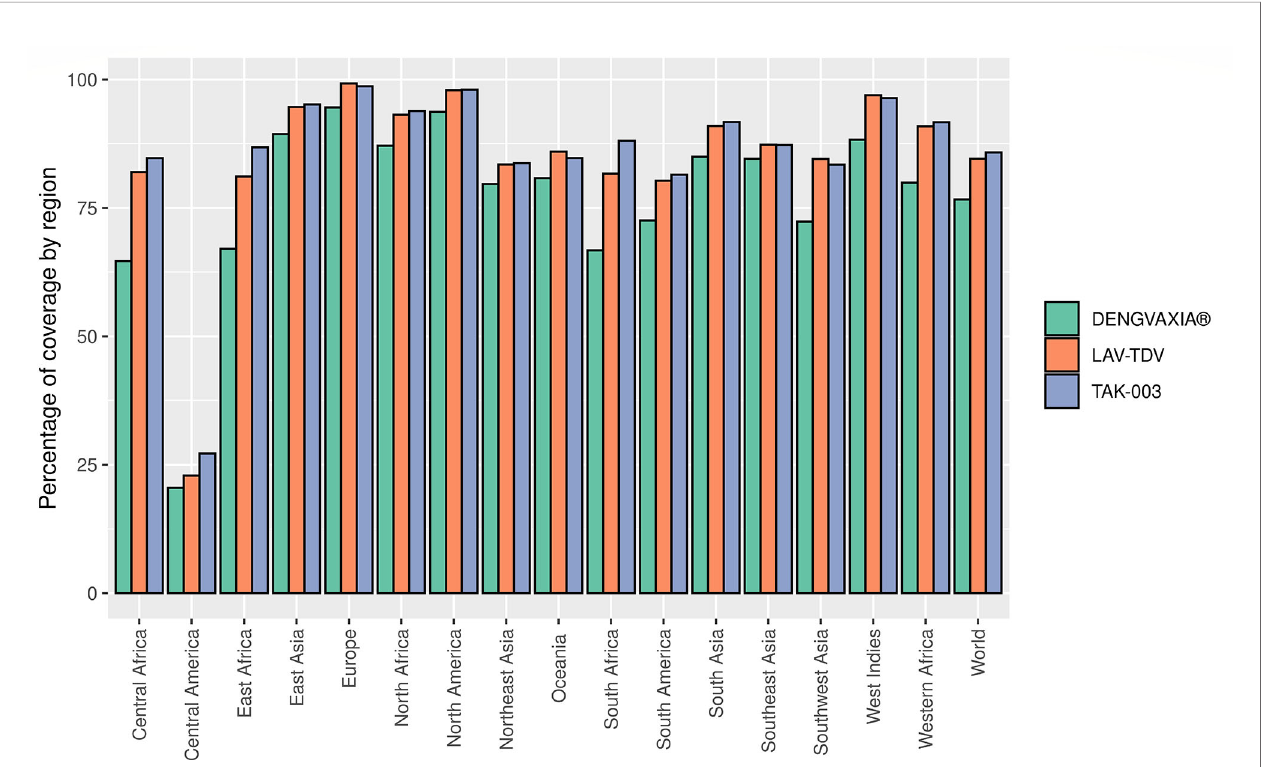
FIGURE 4 | Percentage of coverage predicted for each vaccine based on the presence of a set of epitopes.